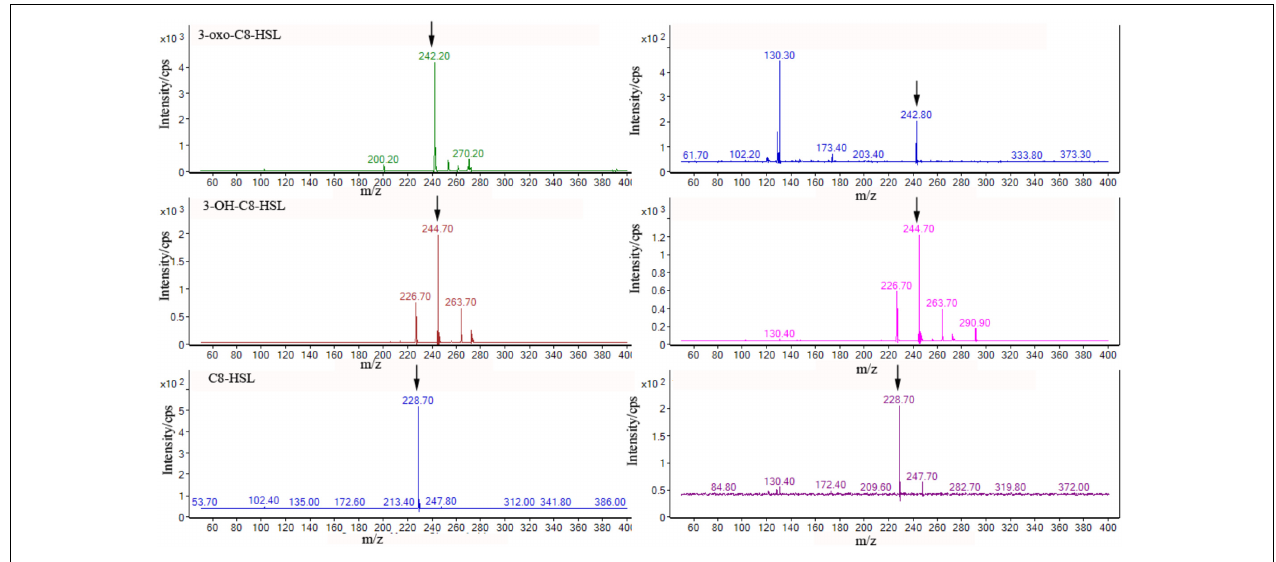
FIGURE 3 | Product ion spectrum of AHLs standards (Left) and the corresponding peak (Right) in the chromatograms of A. veronii LP-11